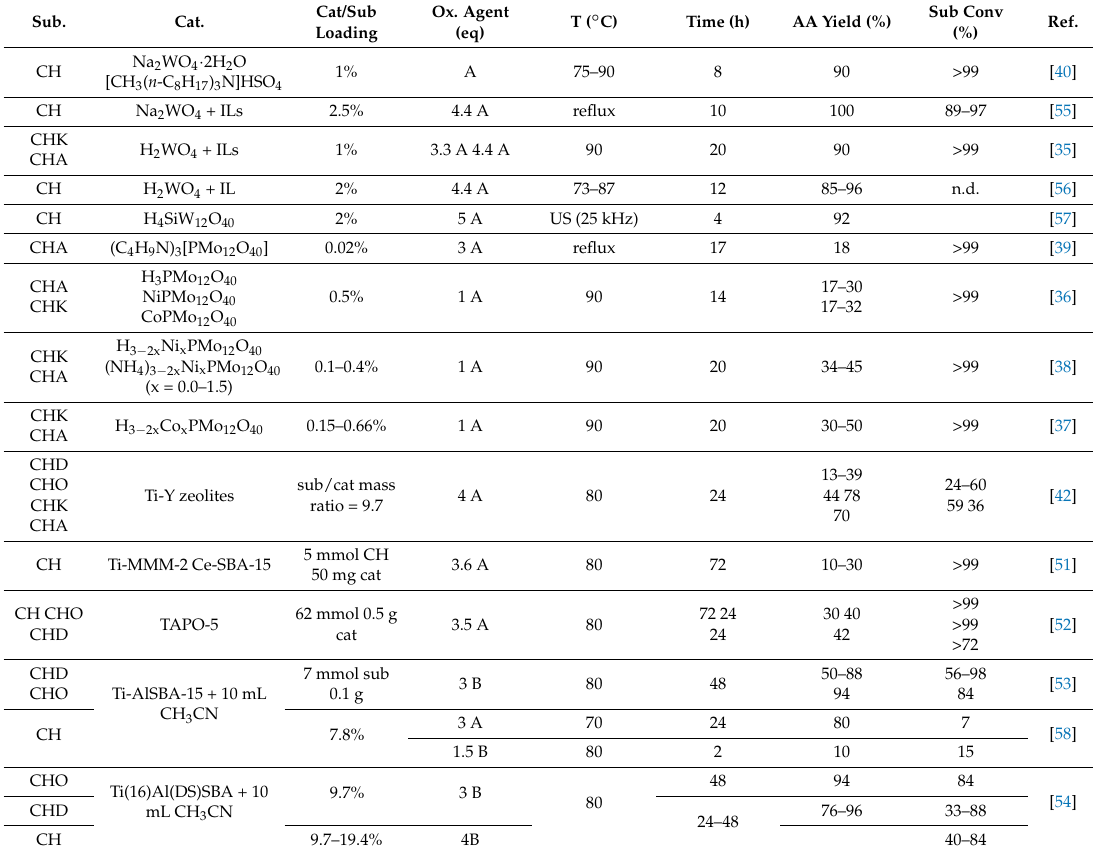
Table 1. Reaction conditions for the preparation of adipic acid from CH, CHO, CHD, CHK, CHA (see footer for abbreviations)—Some literature data with Mo, W-based polyoxometalates (POMs) and mesoporous